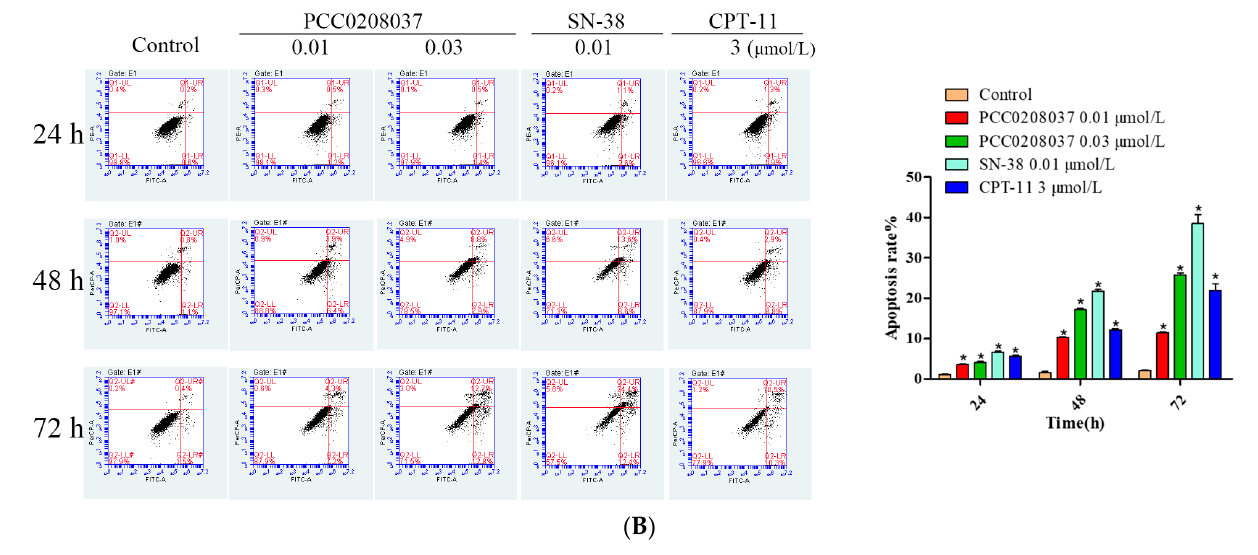
Figure 5 . PCC0208037 induced G 2 /M phase arrest and apoptosis in LS180 cells. ( A ) Cells were treated with multiple concentrations of PCC0208037 for 24, 48, and 72 h and then analyzed by flow cytometry with PI staining. ( B ). Cells were treated with multiple concentrations of PCC0208037 for 24, 48, and 72 h and then analyzed by flow cytometry with annexin VeFITC staining . The data were expressed as the mean ± SD ( n = 3). * p < 0.05 as compared to the control.